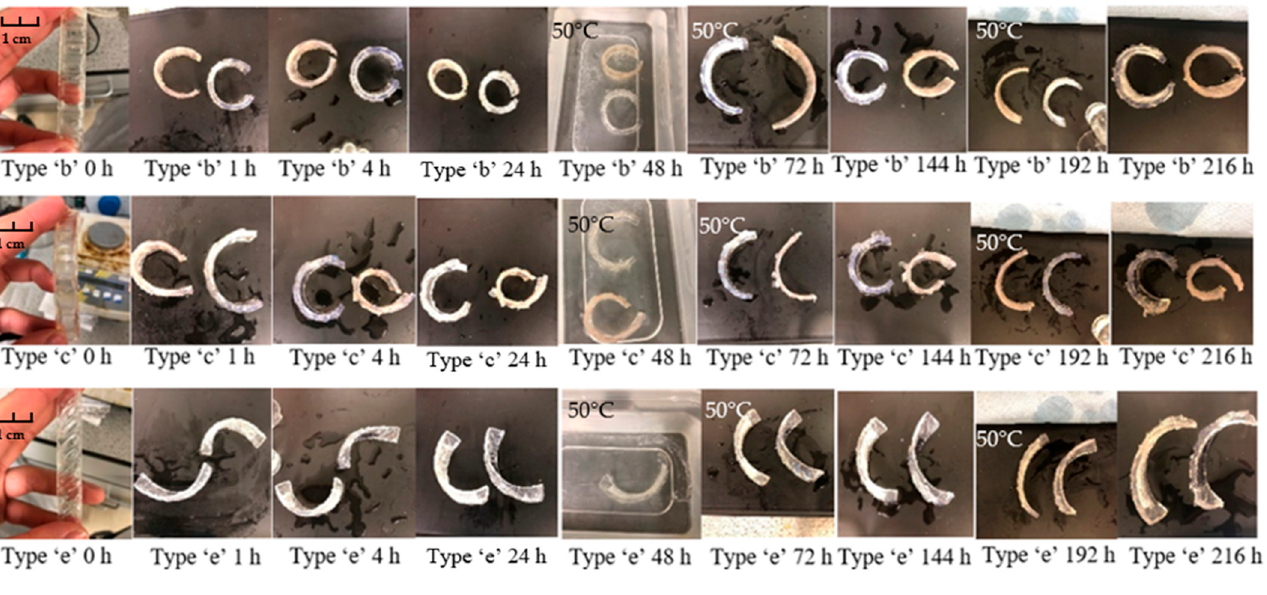
Figure 9. The appearances of swollen type ‘b’, ‘c’ and ‘e’ bilayer samples times: 0 h; 1 h; 4 h; 24 h; 48 h (50 °C); 72 h (50 °C); 144 h; 192 h (50 °C) and 216 h. 48 h (50 ◦ C); 72 h (50 ◦ C); 144 h; 192 h (50 ◦ C) and 216